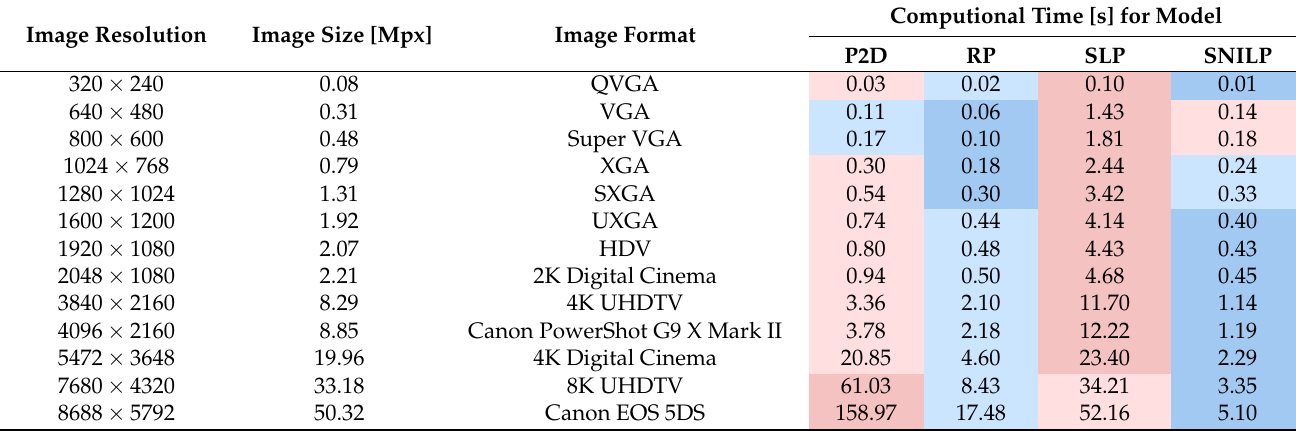
Table 5. Computation times of the tested models for selected image formats and the degree of approximation polynomial s = 5. Image